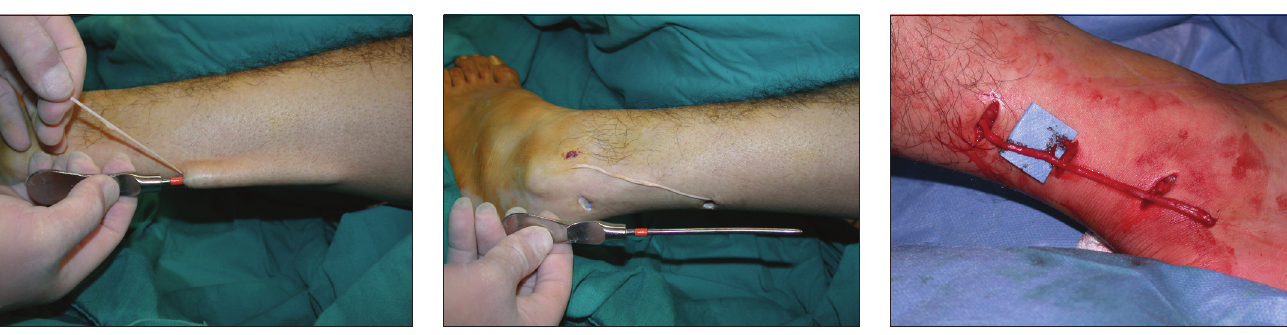
Figure 1. The parameters of histopathologic evaluation that were applied in 11 random patients.